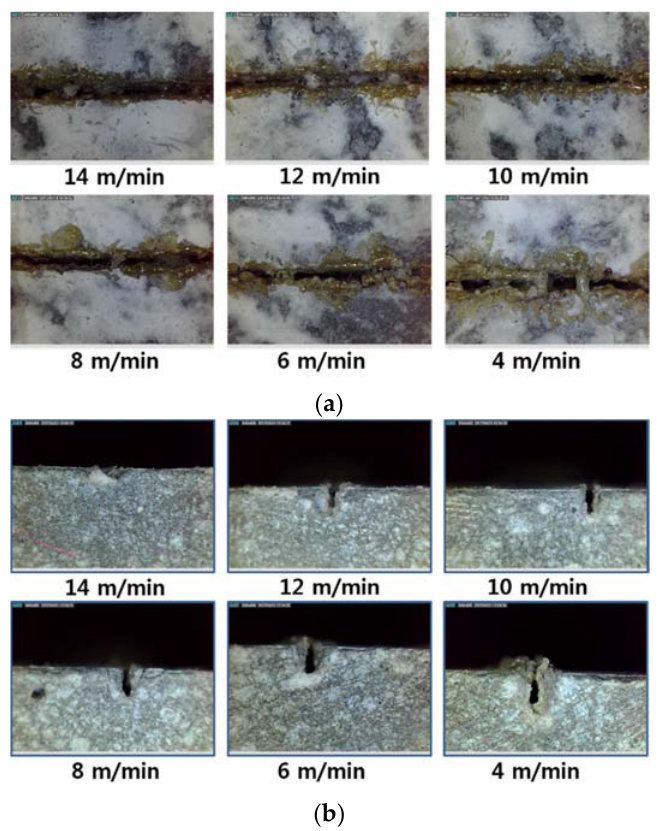
Figure 11. Kerf width ( a ) and penetration depth ( b ) vs. laser moving speed for LU ‐ III.